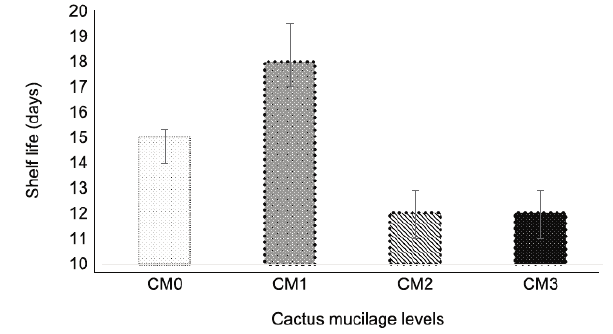
Fig. 2 ­ Effect of cactus mucilage coating on shelf life of bell pep­ per. Error bars indicate ±SE of the mean. CM0 is fruit coa­ ted with 0% cactus mucilage, CM1 is fruit coated with 1% cactus mucilage, CM2 is fruit coated with 2% cactus mucilage and CM3 is fruit coated with 3% cactus mucila­ ge.